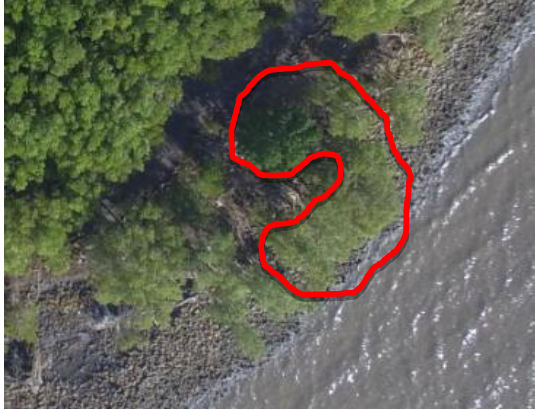
Figure 6. UAV raw image containing the isolated tree crown